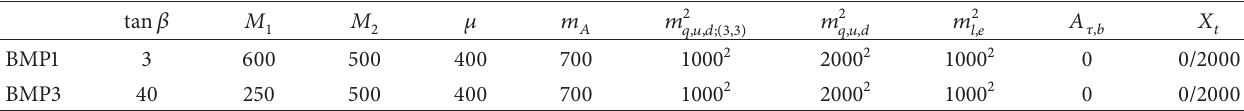
Table 1: Definition of the fixed parameters for the MSSM points in Figures 5(a), 5(b) and 5(c). All parameters in GeV or GeV 2 , where appropriate. The stop mixing parameter 𝑋 𝑡 is given for both cases of no and large stop mixing.